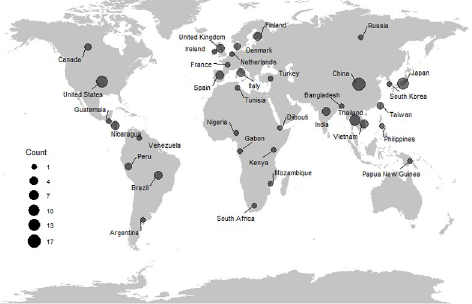
Fig 2. Map of countries in which studies included in sapovirus meta-analysis were